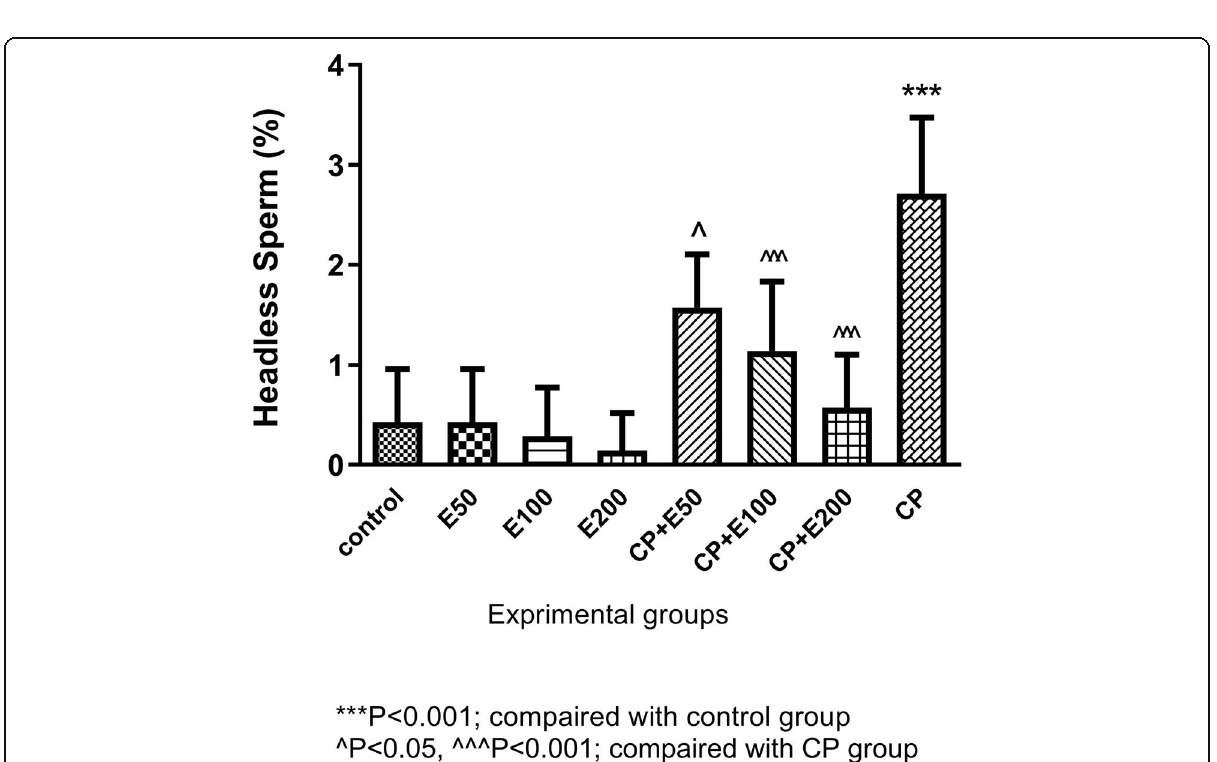
Fig. 6 The effect of Allium atroviolaceum L. extract (E) on headless sperm count in cyclophosphamide (CP)-treated